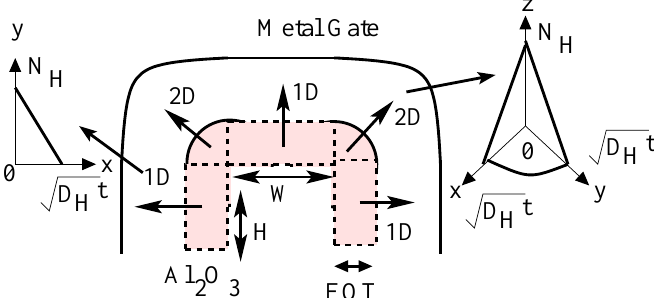
Figure 8. Cross section of the interface at the fin, 1D from the side walls and corners contributes the 2D trap-induced Bias-Temperature-Instability (BTI)